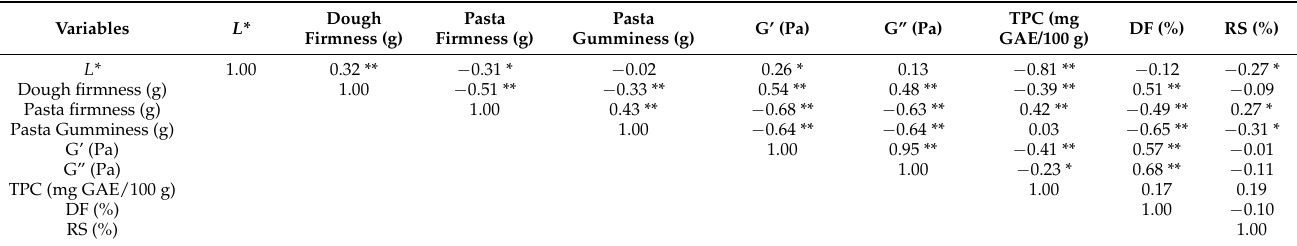
Table 6. Correlations between dough and pasta